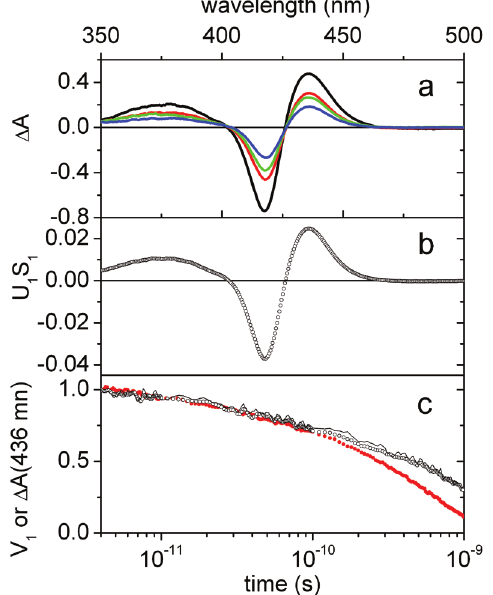
Figure 8. Spectral analysis. ( a ) Time resolved differential absorption spectra for NP7–CO (pH 7.5, T = 20°C) following femtosecond photoexcitation at 532 nm at 4 ps (black line), 200 ps (red line), 400 ps (green line) and 800 ps (blue line) delay times. ( b ) First spectral component ( U ) obtained from the SVD analysis of 1 the time resolved differential absorption spectra multiplied by the corresponding singular value ( S = 0.23). ( c ) Comparison between 1 the time course of the amplitude V (open circles) of the main spectral 1 component obtained from SVD, and the normalized transient absorbance at 436 nm (solid line) as a function of the delay time. The red filled circles report the amplitude V of the main spectral 1 component obtained from the experiment conducted at pH